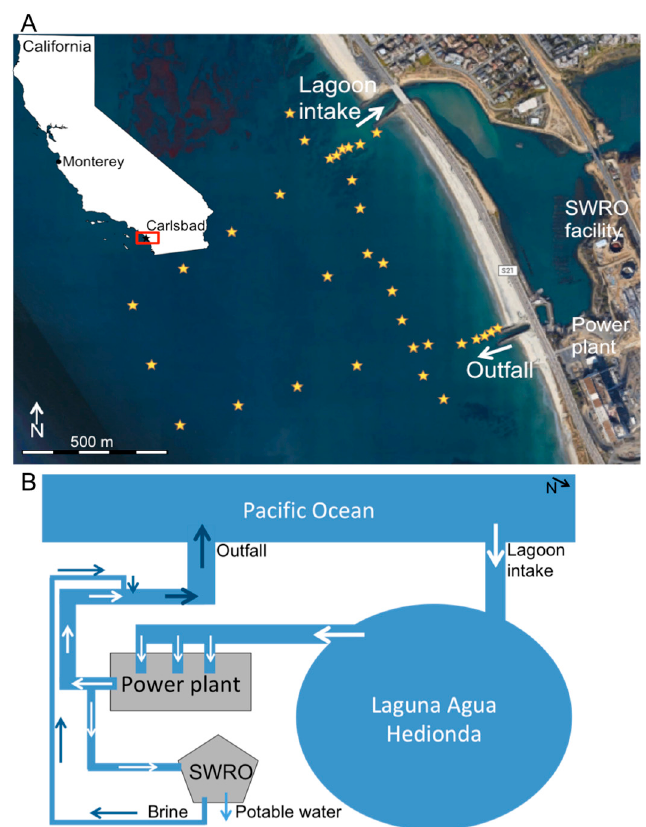
Figure 1. ( A ) Aerial view of the study site around Carlsbad Desalination Plant. The SWRO plant and power plant, intake and outfall channels, and sampling sites (stars) are marked; ( B ) schematic of water flow from the Pacific Ocean to Laguna Aqua Hedionda and the intake and discharge of water by the power plant and SWRO facility (not to scale). White arrows indicate seawater flow and dark-blue arrows represent discharging brine and its mixture with the power plant’s seawater return flow.